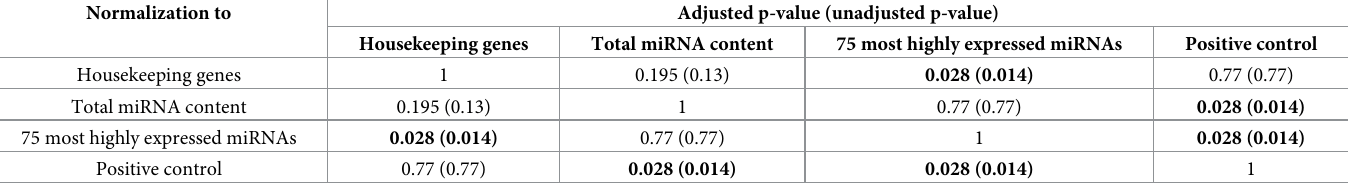
Statistically significant differences are in bold (adjusted p <